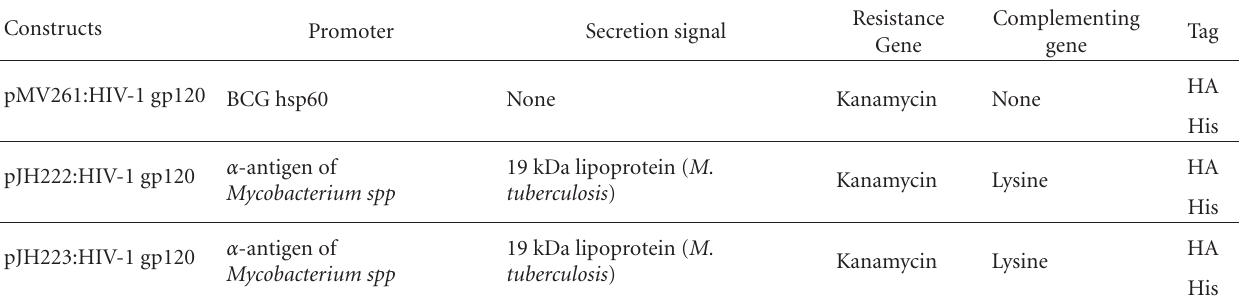
Table 3: Constructs obtained using E. coli /mycobacterial shuttle expression vectors to express HIV-1gp120 antigen (HXBc2). Constructs Promoter Secretion signal Resistance